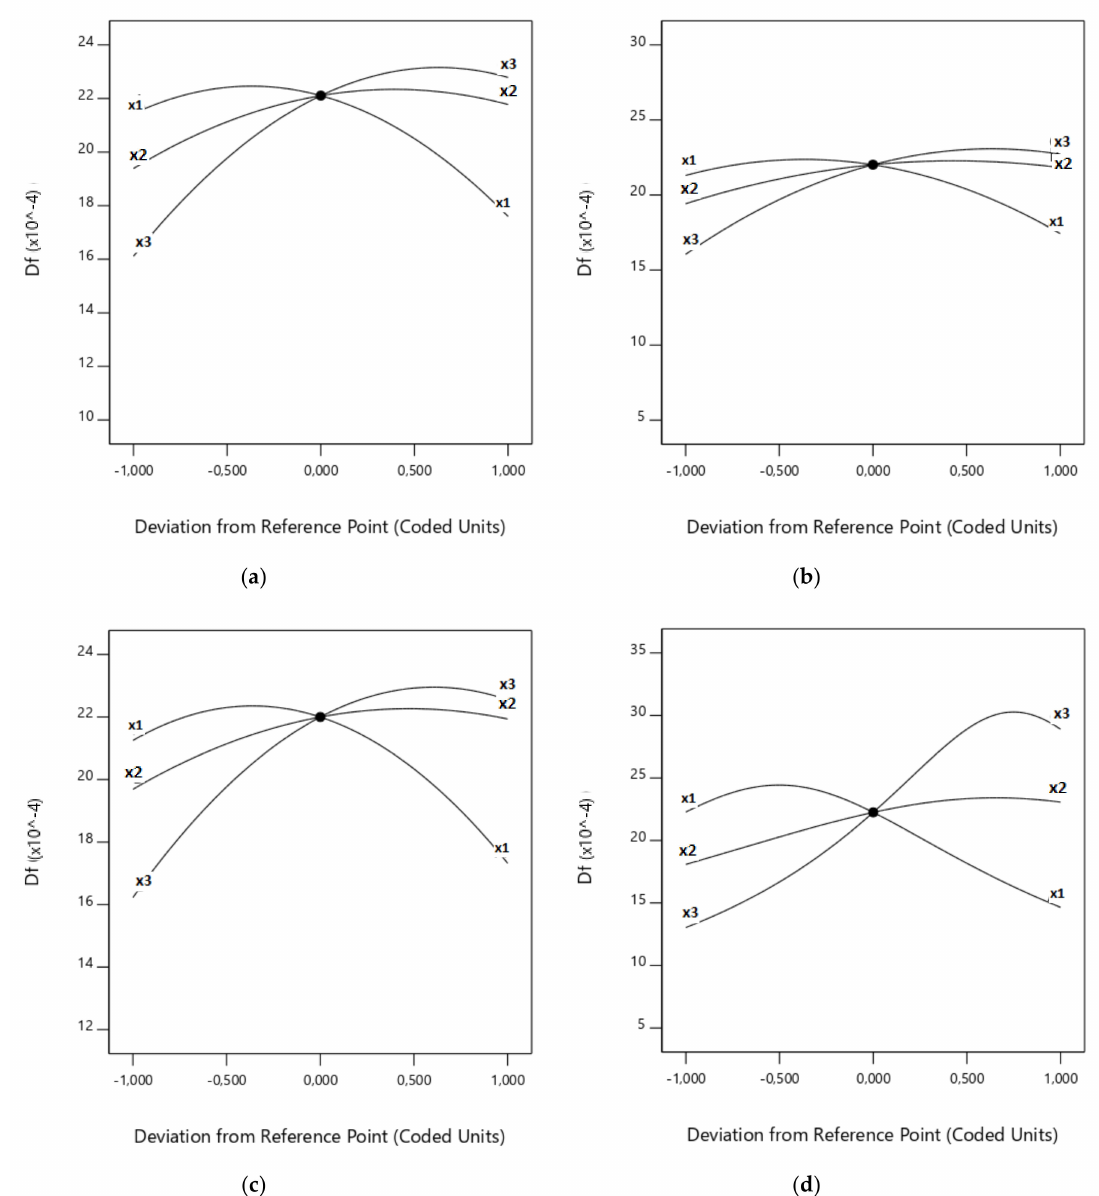
Figure 9. Influence of factors on D f : ( a ) Complete design; ( b ) Central composite design; ( c ) Box–Behnken design; and ( d ) Central composite design with power